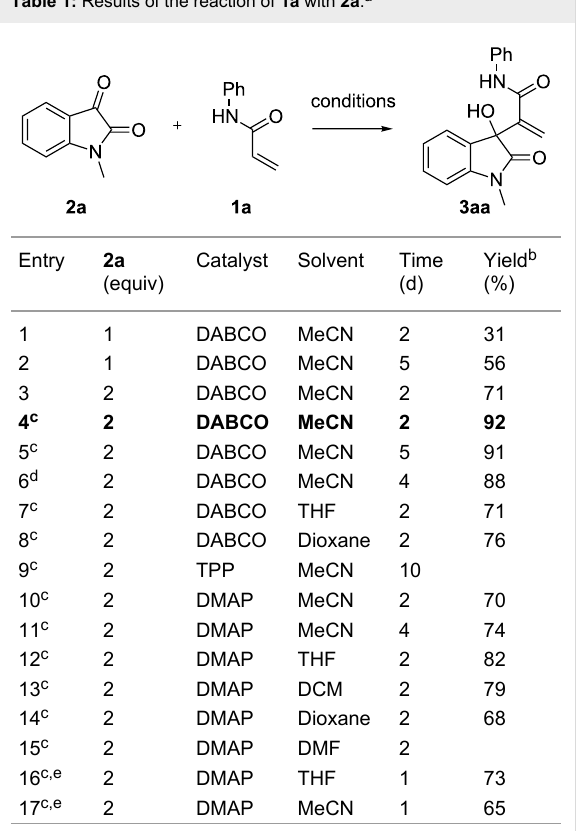
Table 1: Results of the reaction of 1a with 2a .